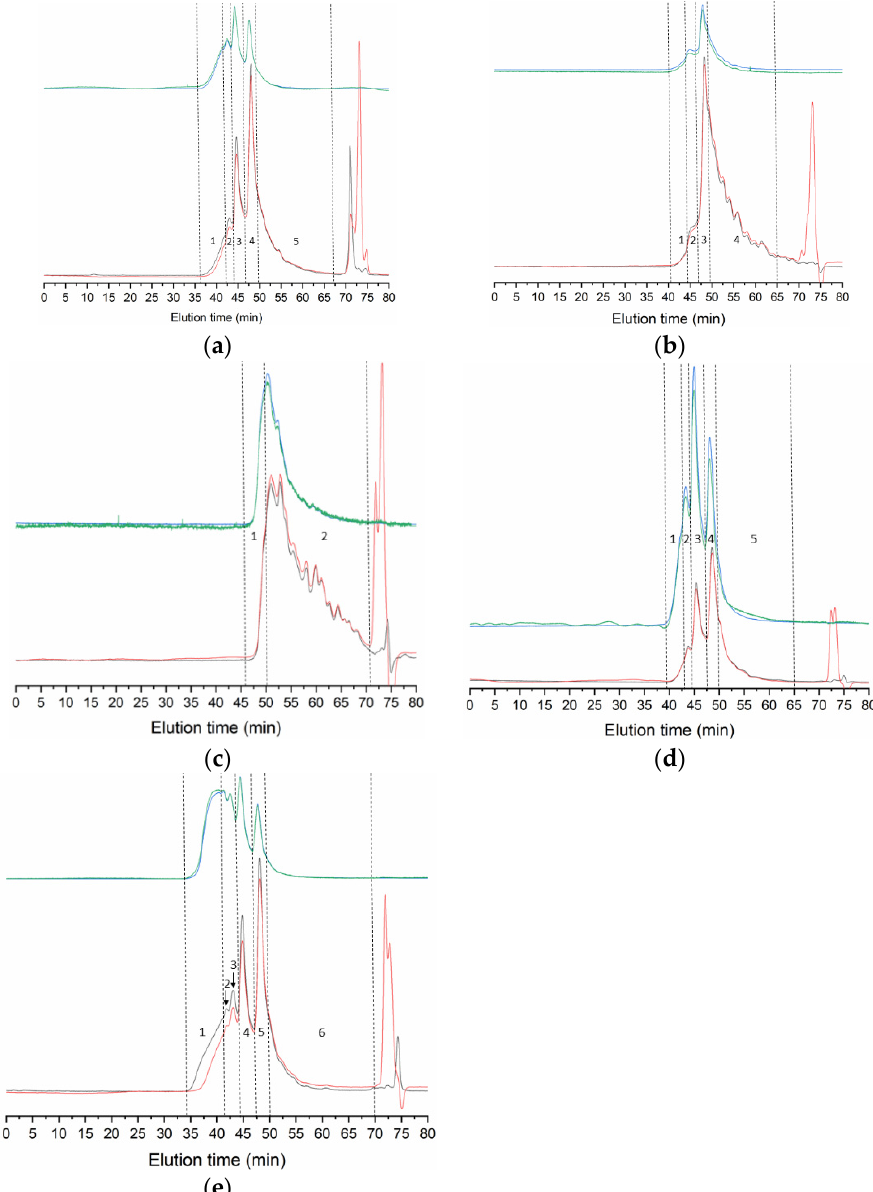
Figure 1. GPC eluograms of gelatin extracted from the skin of salmon by different methods: P1 ( a ), P2 ( b ), P3 ( c ), P4 ( d ), and P5 ( e ). Blue line: right angle light scattering; green line: low angle light scattering; red line: refractive index; and black line: ultraviolet (232 nm). Details of the numbered peaks/regions can be found in Table